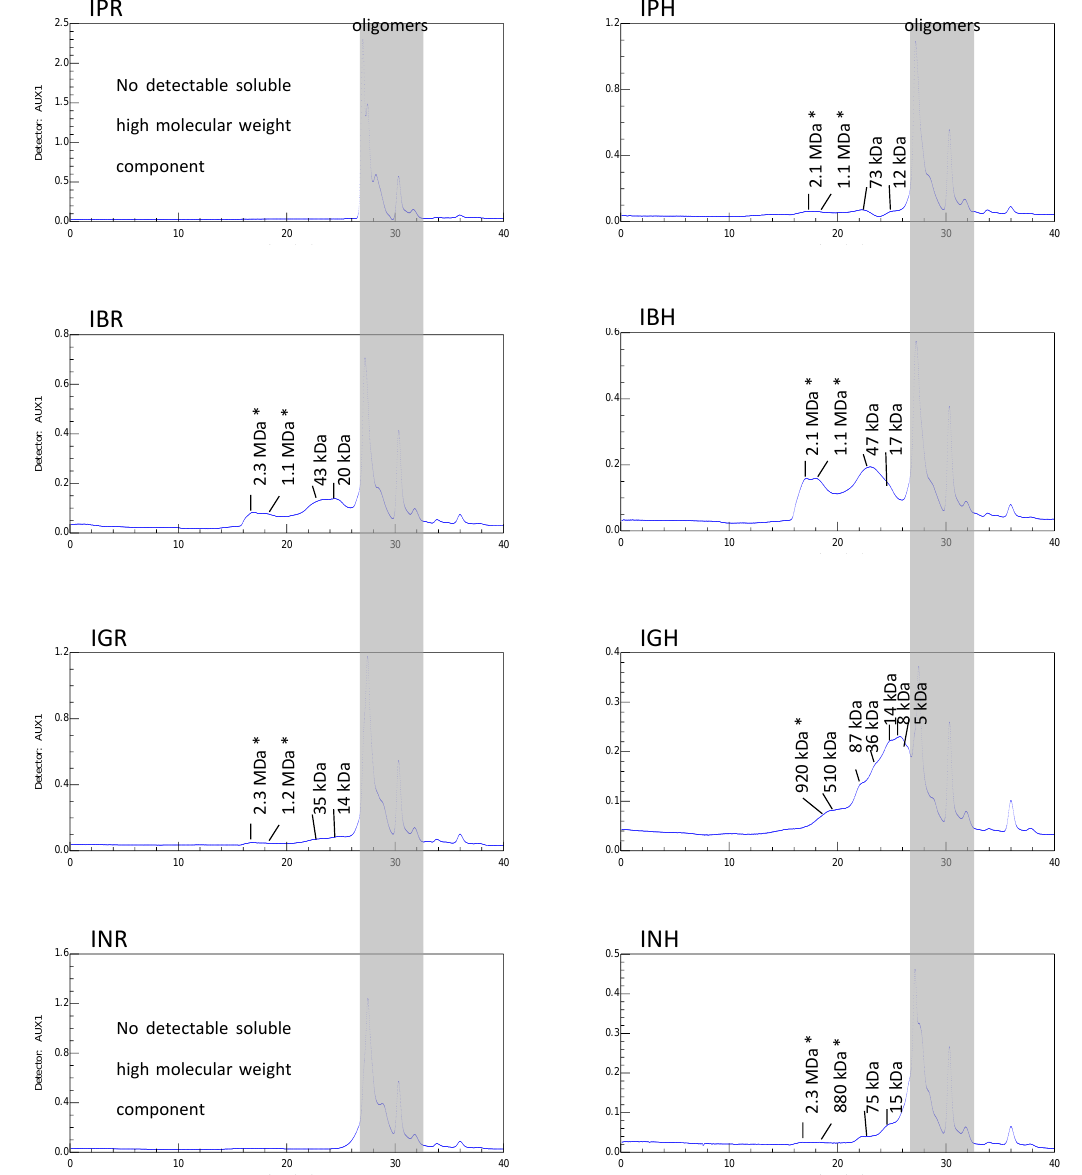
Figure 2. Size-exclusion chromatography (SEC) chromatograms of polysaccharides of Impatiens species. * The molecular weights out of calibration (the linear equation generated by the standard curve was y= −1.588ln(x) + 39.768; R 2 = 0.9986). A simple gel diffusion assay with all the samples was done [25]. A precipitation line